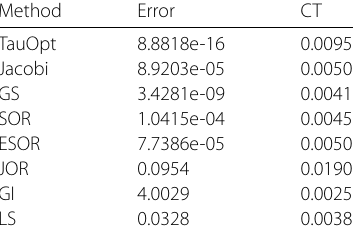
Table 2 Error and CT for Ex. 4.1